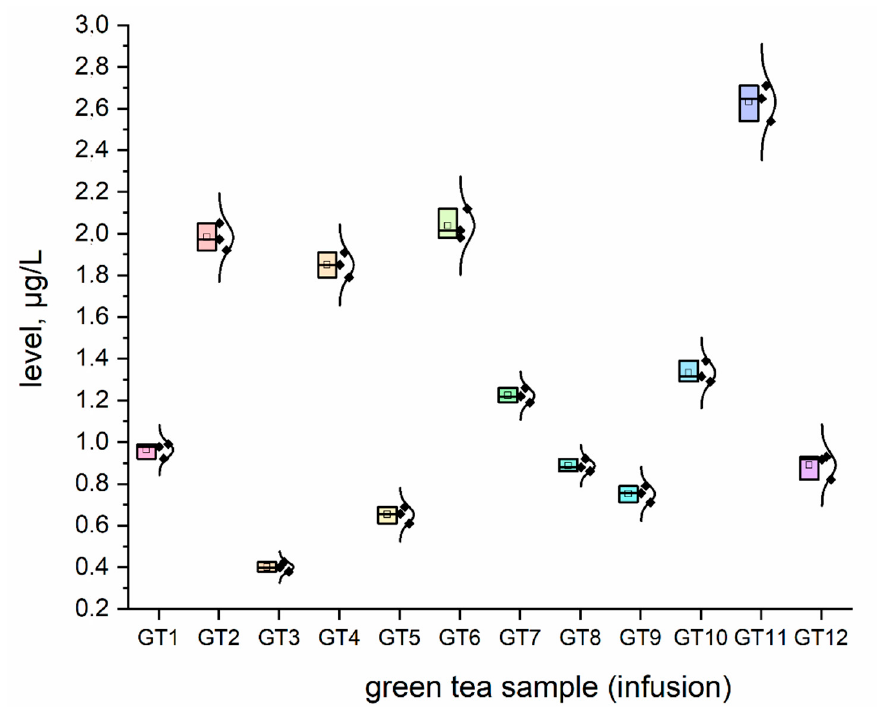
Figure 3. The plot as a box chart, with a normal distribution curve for Cs concentration ( µ g/L) in analysed green tea samples (infusions; GT1–GT12). The colors indicate the results for the individual tested samples, the symbol indicates the standard deviation.